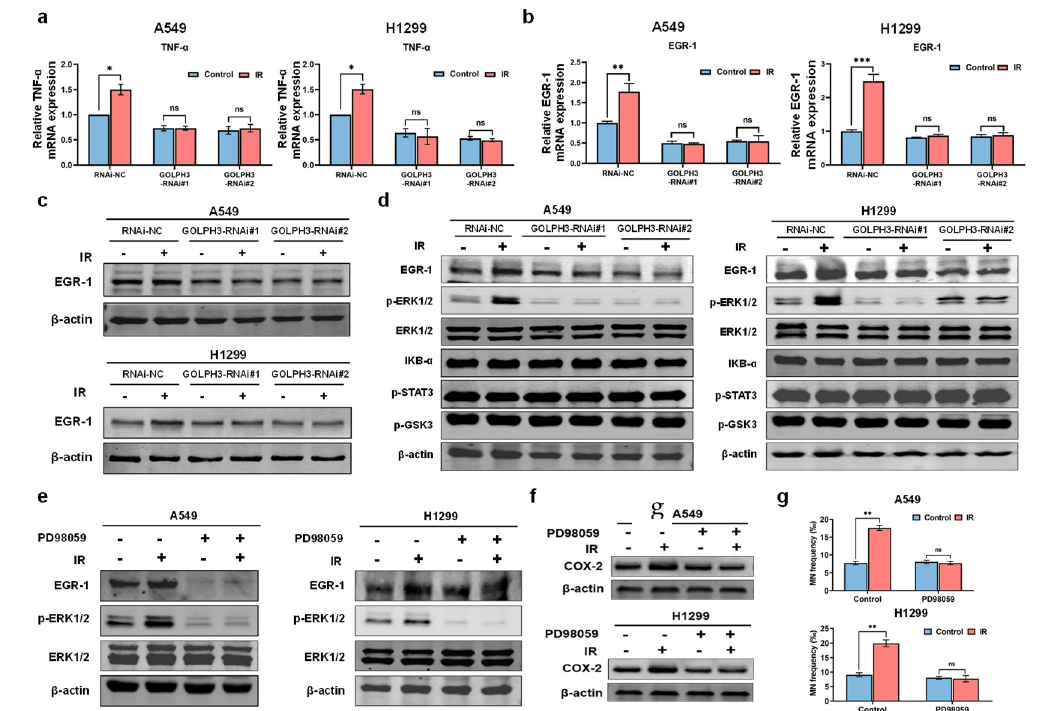
Figure 4. GOLPH3 regulates the transcription of TNF- α via ERK/EGR1 pathway. ( a , b ) Relative mRNA expression of TNF- α ( a ) and EGR1 ( b ) after IR in RNAi-NC, GOLPH3-RNAi#1 and GOLPH3-RNAi#2 cells, respectively; ( c ) the expression of EGR1 protein after irradiation; ( d ) detection of ERK, STAT3, GSK3 β and NF- κ B pathway activation in the indicated cells (1.5 h after IR); ( e ) EGR1 expression in irradiated A549 and H1299 cells with or without the ERK inhibitor (PD98059) treatment; ( f ) COX-2 expression in the bystander cells (A549 or H1299) after treating the irradiated cells with the ERK inhibitor; ( g ) MN yields in the bystander cells (A549 or H1299) after treating the irradiated cells with the ERK inhibitor. *: p < 0.05; **: p < 0.01; ***: p < 0.001; ns: not significant.